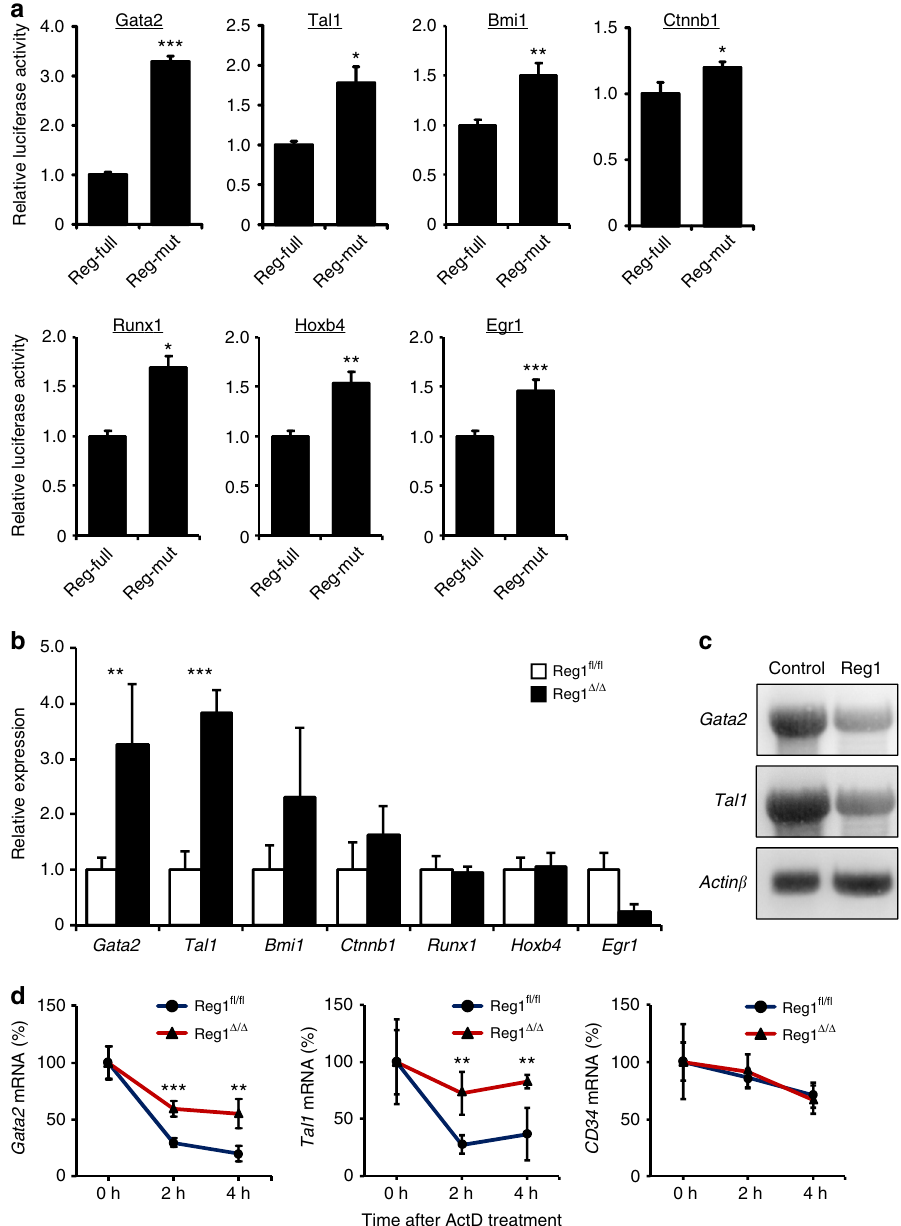
Fig. 6 Regnase-1 recognizes and degrades Gata2 and Tal1 mRNA. a Luciferase activity of HEK293 cells transfected with luciferase reporter plasmids containing 3 ′ UTRs of the indicated genes and either Regnase-1 expression plasmid or inactive Regnase-1 mutant plasmid (3 independent experiments). b qRT-PCR analysis of candidate gene expression in CD34 − HSCs from control ( fl / fl ) or Regnase-1-KO ( Δ / Δ ) mice BM ( n = 3 per group; 3